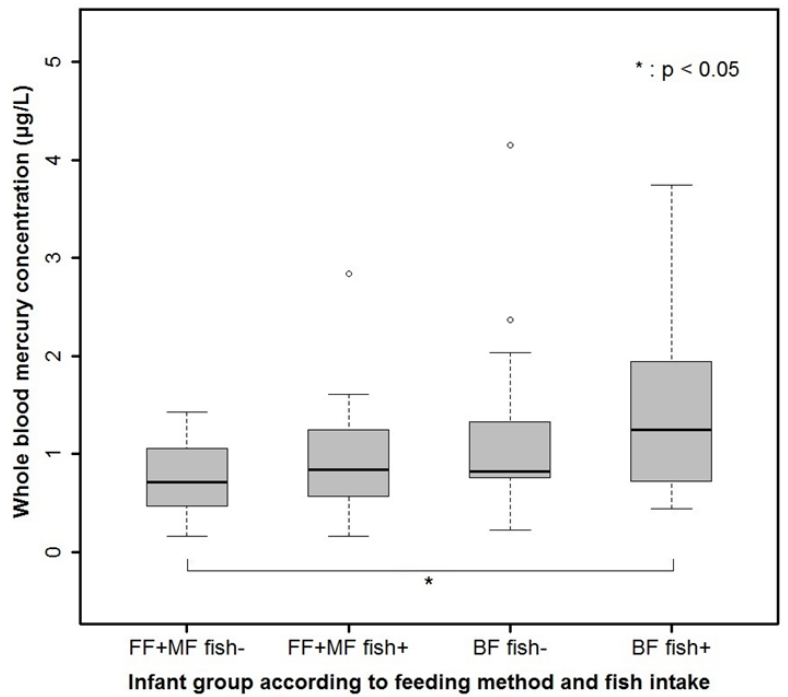
Figure S4. Hair mercury content in four categorized groups of infants according to the feeding method and fish intake ( p = 0.012). FF+MF: mostly formula feeding + mixed feeding, BF: mostly